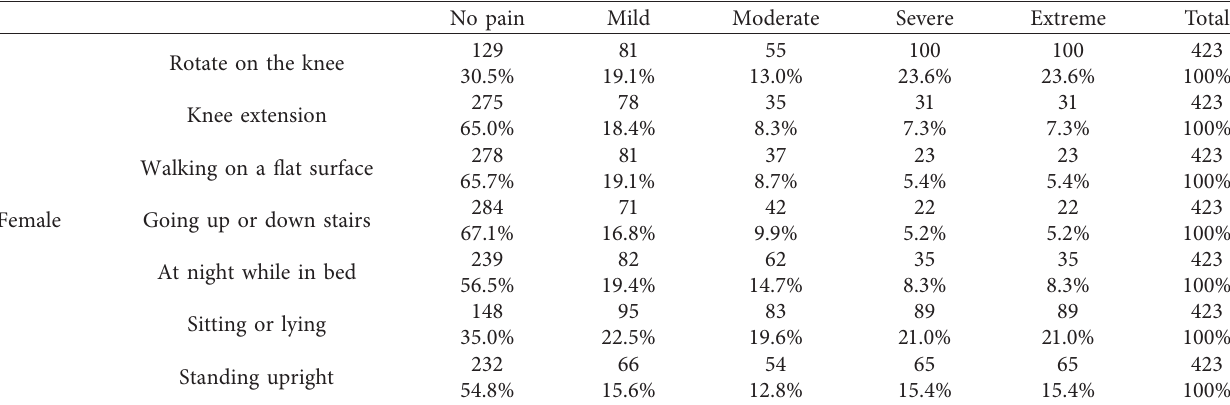
Table 6: The prevalence of gender-based knee pain in the studied participants.